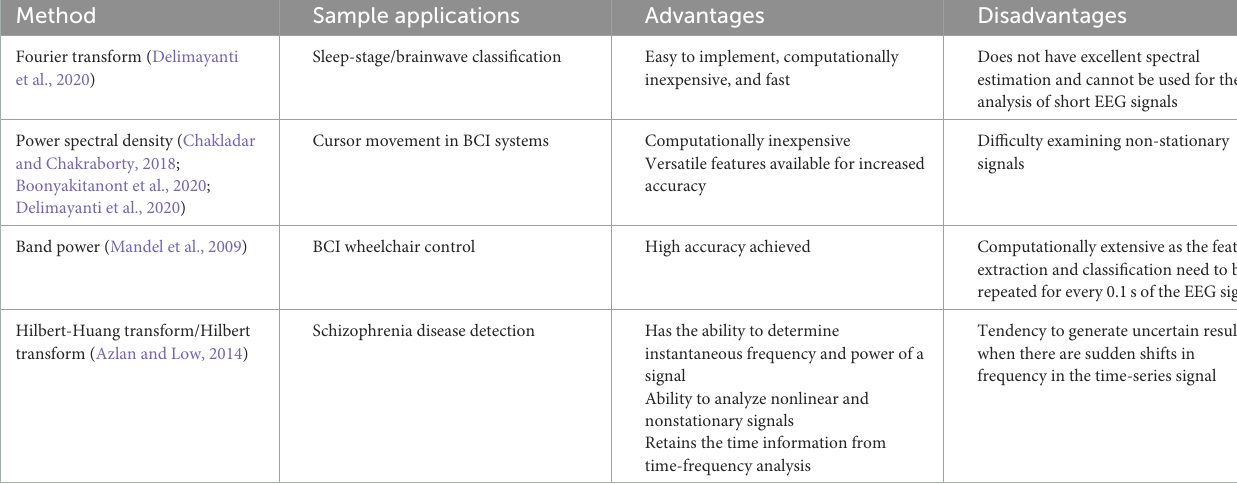
TABLE 2 Summary of frequency-domain feature extraction methods for EEG.